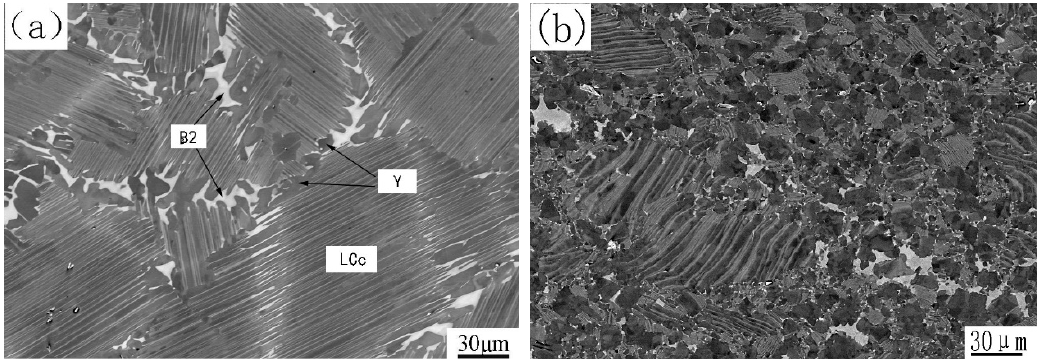
Figure 1. Microstructures of the as-cast alloy ( a ) and the as-forged alloy ( b ).